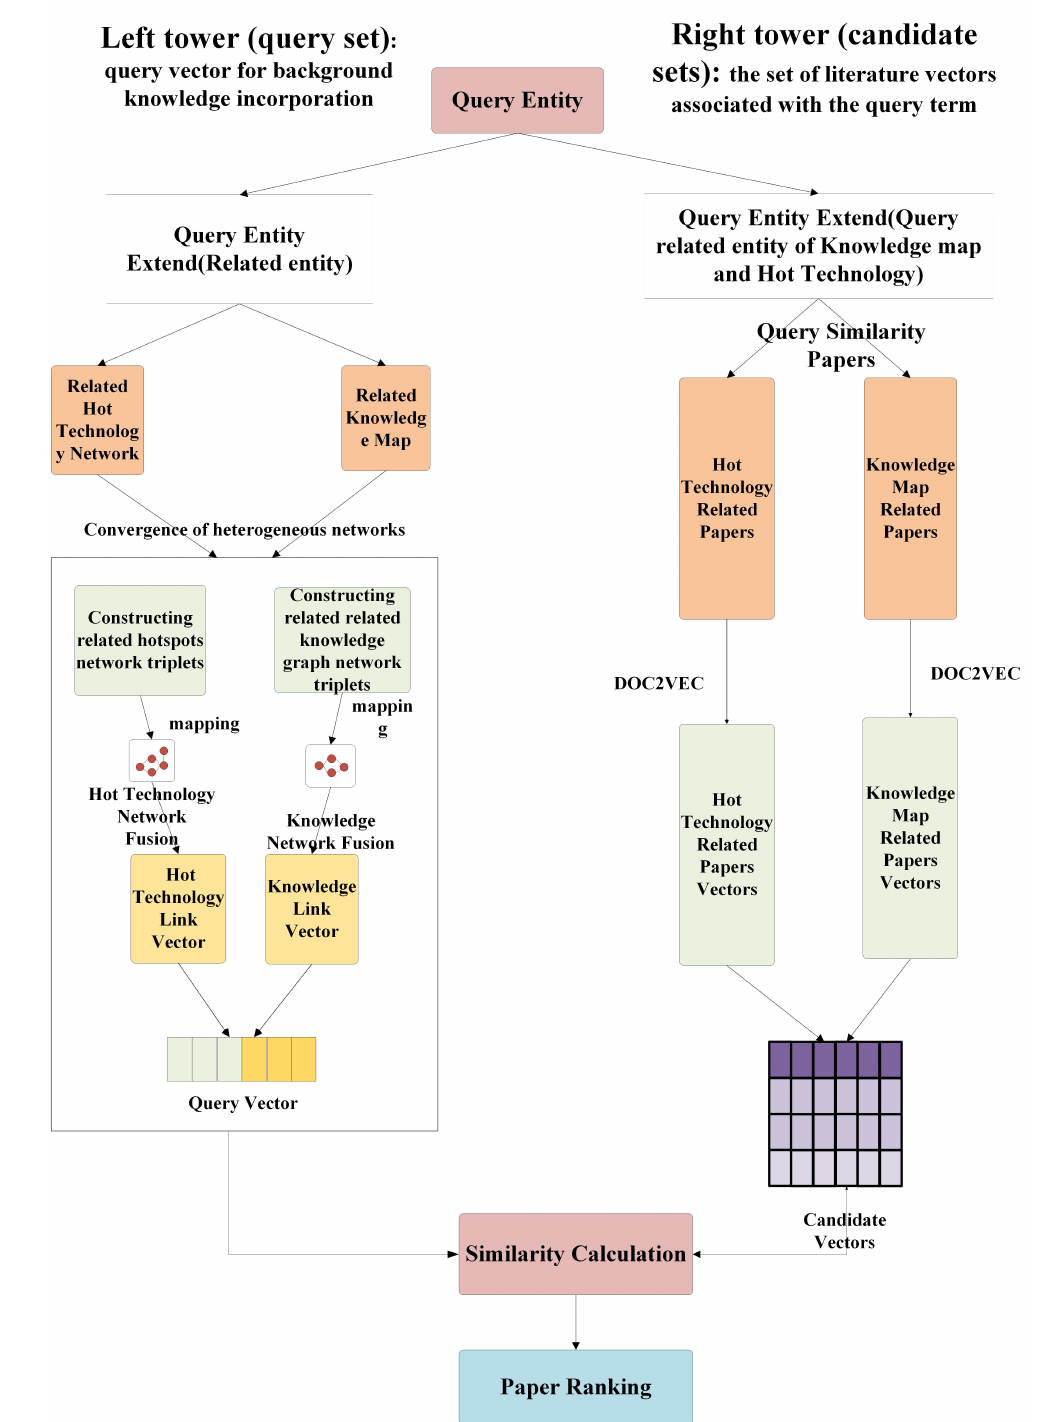
Figure 1. A noval scientific paper recommendation model via heterogeneous network embedding- based knowledge graph and